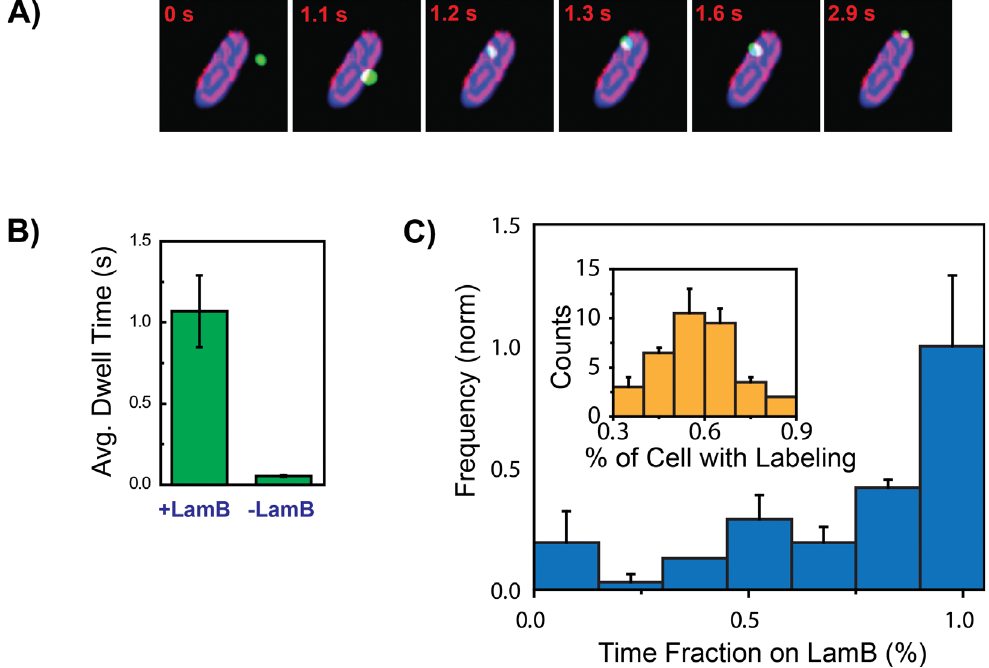
Figure 5. Viral motion on the cell surface is dominated by the interaction with LamB receptors. ( A ) Time- lapse images of the colocalization of a free virus (green) moving on a cell (blue) with LamB receptor bands (purple). The virus is observed to be predominantly moving on the LamB receptor bands (scale bar = 2 µ m). ( B ) The mean dwell times of viruses on host c ell with (+LamB) and without (−LamB) LamB. ( C ) Colocalization dwell- time analysis of 70 unbound viruses moving on cells with labeled bio LamB, showing the distribution of the fraction of a trajectory the viruses spent on LamB regions, with strong prevalence for residing in highly labeled, receptor-rich regions. Inset: Distribution of the cell area (fraction of entire area) with labeled receptors. Adopted and modified after